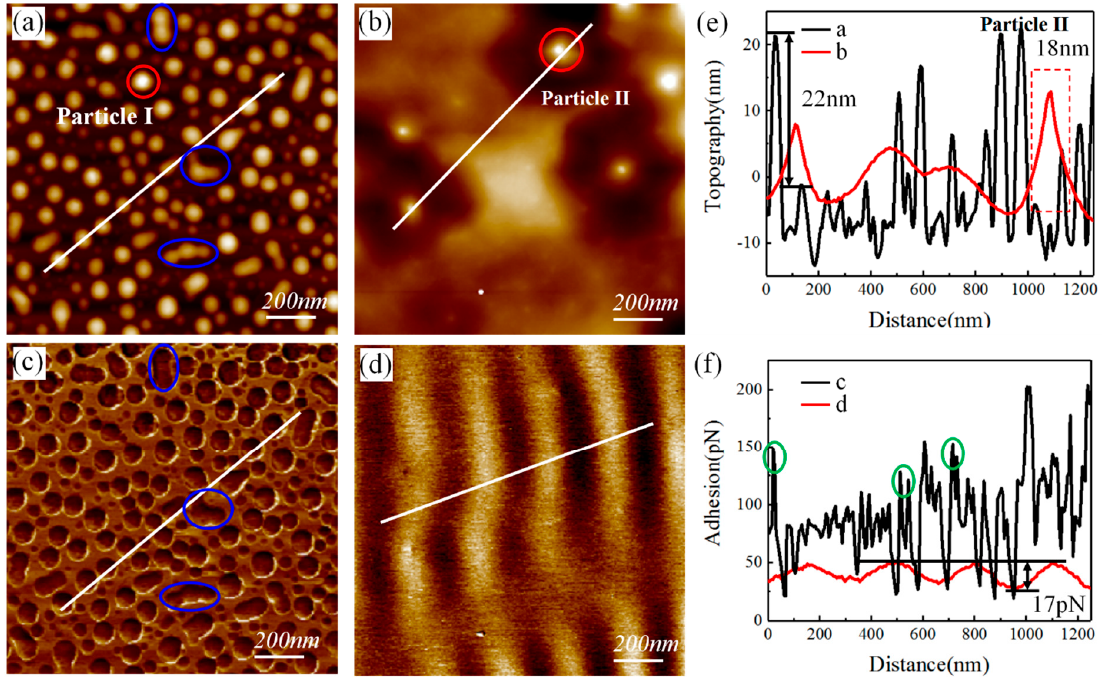
Figure 6. Paraffin coating produced by closed-type precise temperature-controlled evaporation for 8 min and 25 min: ( a ) topography with evaporation for 8 min; ( b ) topography with evaporation for 25 min; ( c ) adhesion corresponding to ( a ); ( d ) adhesion corresponding to ( b ); ( e ) cross section of the topography corresponding to ( a , b ); and ( f ) cross section of the adhesion corresponding to c and ( d ). The blue circled areas are gathered paraffin particles.